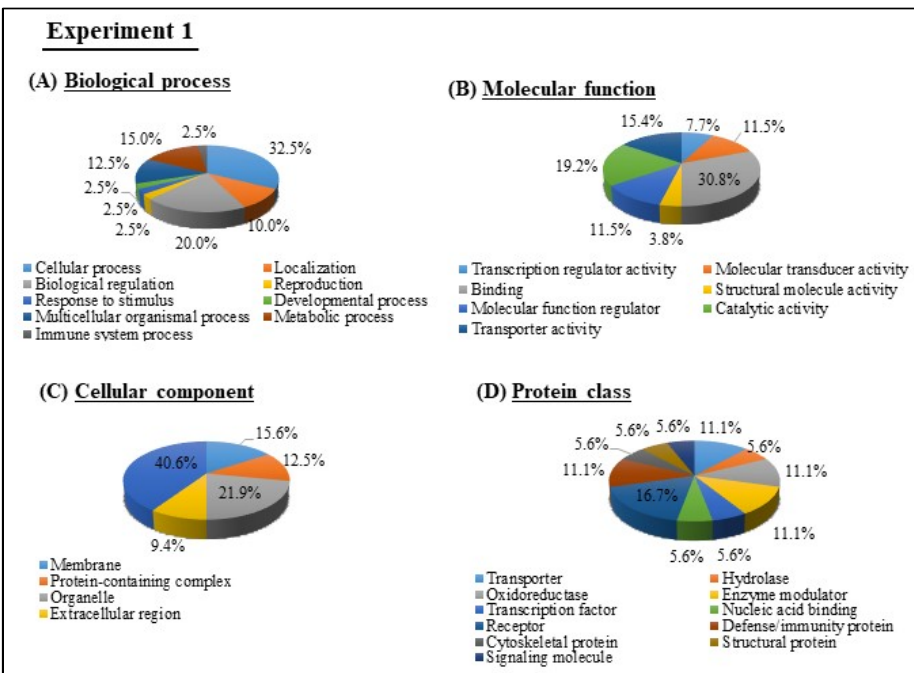
Figure 3. Gene ontology (GO) of DEGs in milk EVs from BLV-infected cattle with HPL in Experiment 1 were analyzed and categorized according to biological processes ( A ), molecular functions ( B ), cellular components ( C ), and protein class ( D ), using PANTHER analysis. Viruses 2020 , 12 , x FOR PEER REVIEW